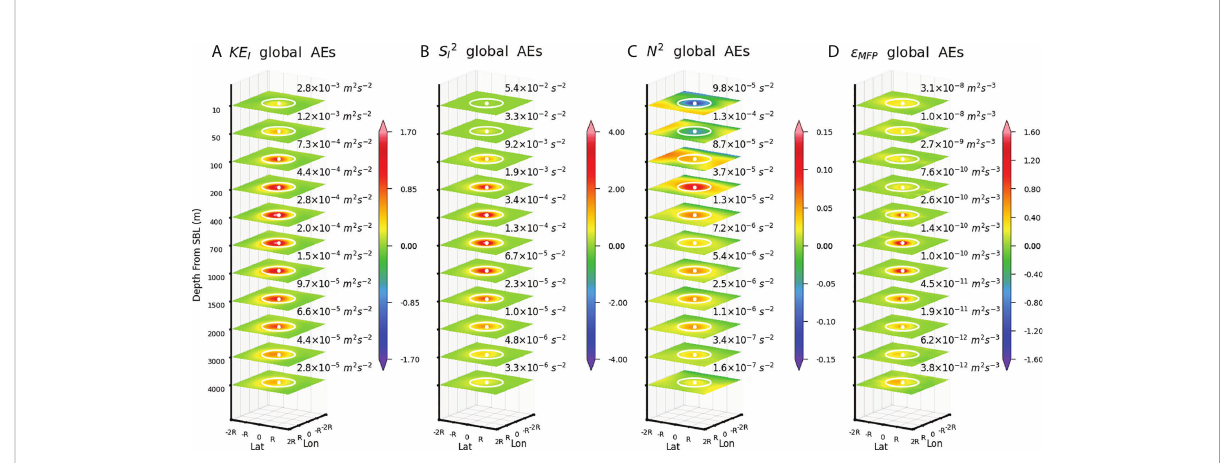
(A) Relative difference of the composite KE I with respect to its background value, ð KE I (cid:3) KE Ib Þ =KE Ib , for AEs in the global ocean. The value of KE Ib is denoted above each horizontal slice. (B – D) Same as (A) but for S 2 I , N 2 , and ϵ